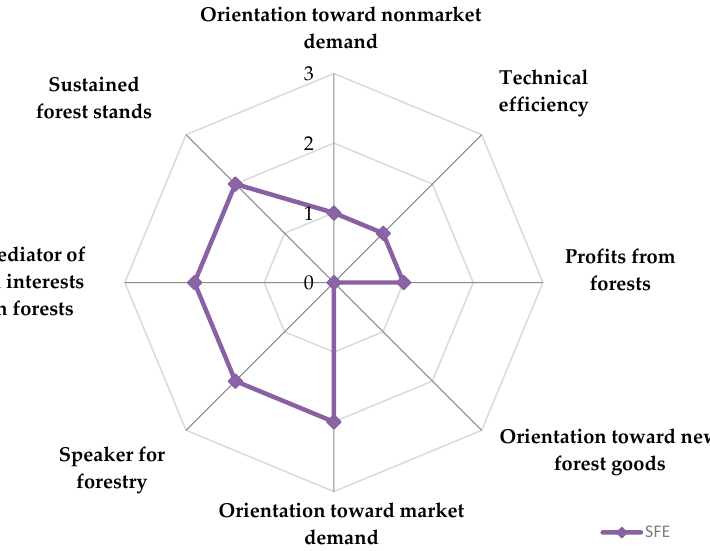
Figure 2. Performance of forest institutions with management tasks in Republic of Moldova: (0) for no performance, (1) for weak performance, (2) for moderate performance and (3) for strong perfor- mance.